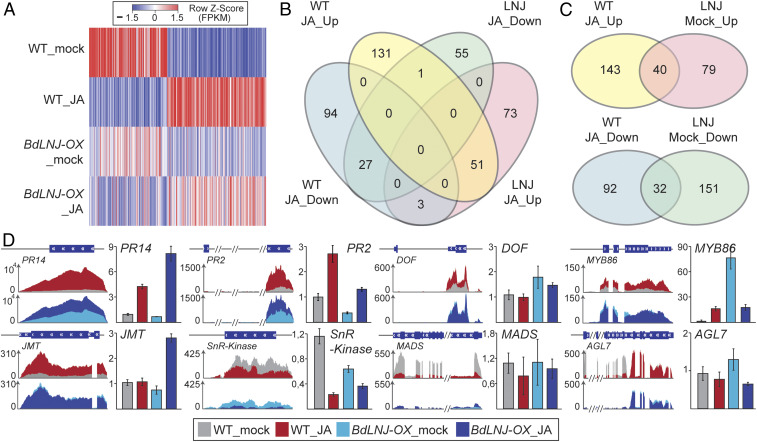
BdLNJ globally affects jasmonic acid signaling. (A) Heat map of differentially expressed genes in wild-type Brachypodium (WT_mock/WT_JA) and BdLNJ-OX plant (LNJ-OX_mock/LNJ-OX_JA) with and without MeJA (mock/JA). The color scale indicates gene expression level (FPKM values). For each genotype and treatment, two biological samples were analyzed. (B) Venn diagram showing DEGs expressed in the four samples. WT indicates wild-type Brachypodium and LNJ indicates BdLNJ-OX plant. The number of genes of JA_UP or JA_Down indicates up-regulated or down-regulated genes in response to MeJA treatment. (C) Venn diagrams showing genes that were significantly induced after MeJA treatment (FDR ≤ 0.05). Induced genes were defined as transcripts with fold changes ≥2 based on gene expression levels between WT JA_UP and LNJ Mock_UP, between WT JA_Down and LNJ Mock_Down, respectively. (D) Validation of candidate genes identified by RNA-Seq using qRT-PCR. RNA-Seq read coverages of genes that are up- or down-regulated in response to MeJA treatment. Gene models depict exons in blue. QRT-PCR analysis of differential gene expression in MeJA treated wild-type Brachypodium and BdLNJ-OX plant, n = 3. RNA-seq read maps and qRT-PCRs show mock-treated wild-type Brachypodium in gray and wild-type MeJA-treated samples in red. The mock-treated BdLNJ-OX samples are shown in light blue and corresponding MeJA-treated samples in dark blue.